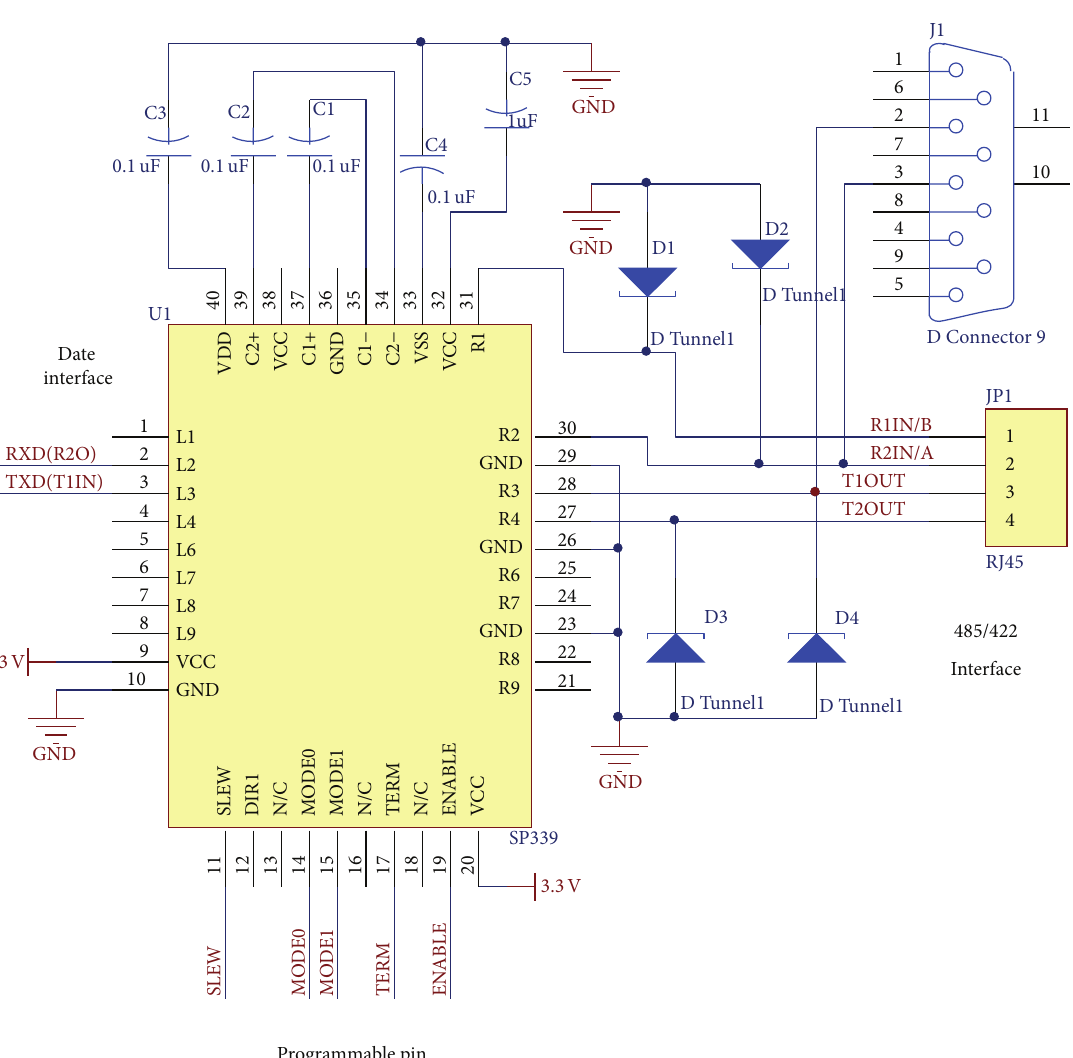
Figure 1: The circuit of communication